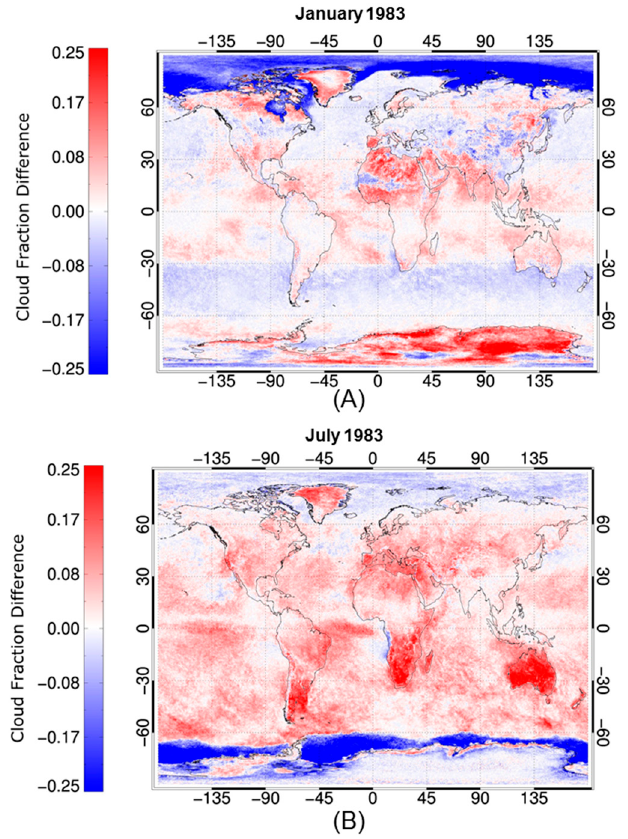
Figure 5. Cloud fraction difference for January 1983 ( A ) and July 1983 ( B ) for the CLARA-A2 climatology after applying channel 3b noise filter and a rounding error correction (approximately − 0.01 everywhere). Observe that the figure shows unfiltered minus filtered CLARA-A2 results, i.e., red colours indicating reduction after filtering and blue colours an increase after filtering. The globally averaged cloud fraction difference in January 1983 was +0.4% and in July 1983 + 4.2%.